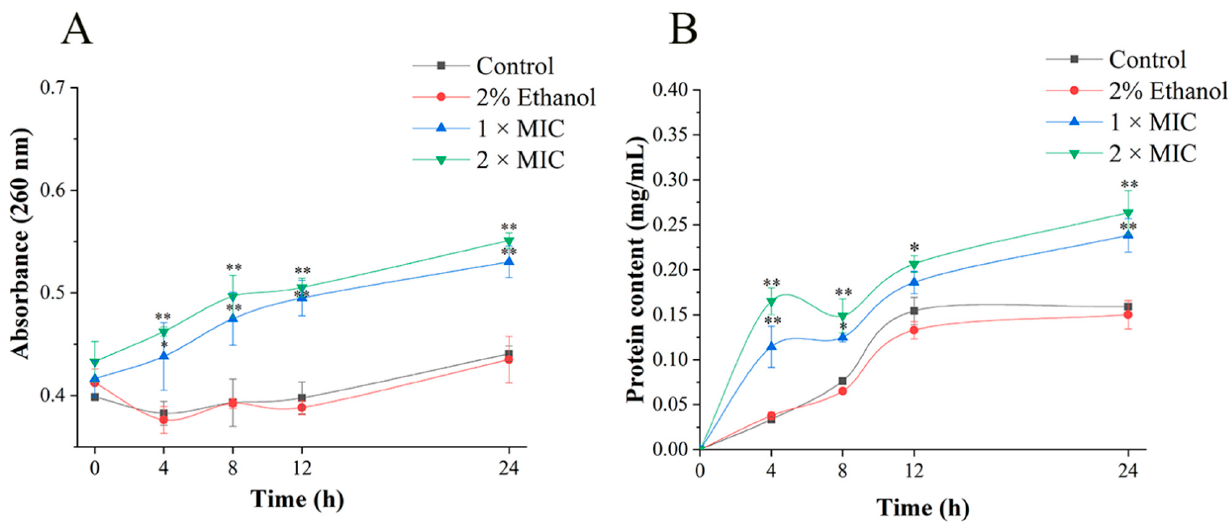
Figure 5. Effect of 3-carene on the release of extracellular nucleic acid ( A ) and protein ( B ). The asterisks indicate statistically significant differences compared with the control ( * p < 0.05; ** p < 0.01).